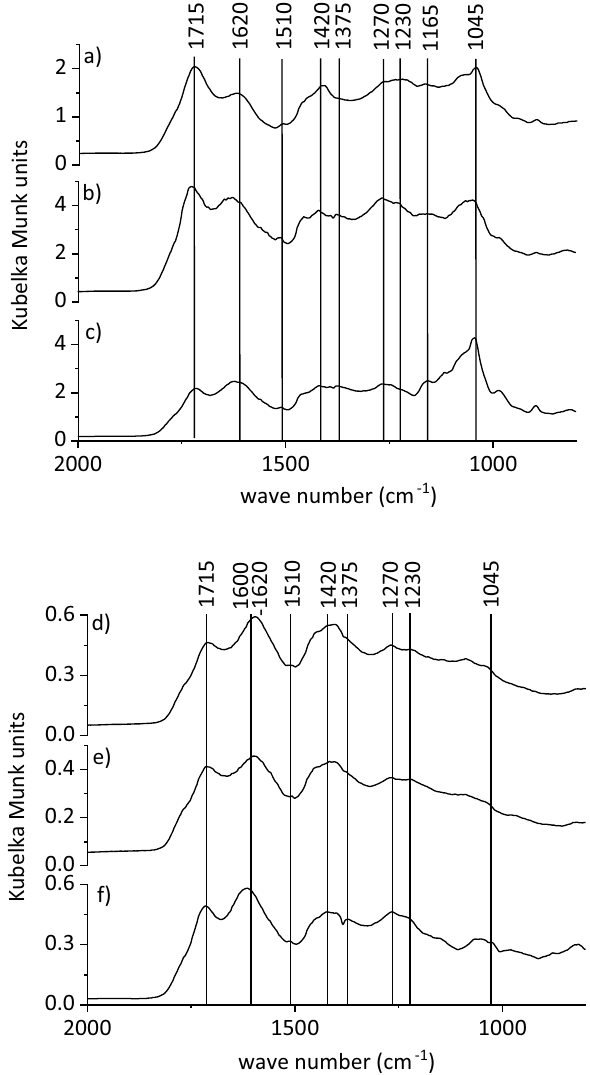
Figure 3. Exemplary partial diffuse reflectance infrared Fourier transform spectra of freeze-dried eluates taken from the slow ( a – c ) and fast run ( d – f ) after the first irrigation phase ( a , d ), after resuming the flow after 30 days of flow interruption ( b , e ), and after resuming the flow after 3 days of flow interruption ( c , f